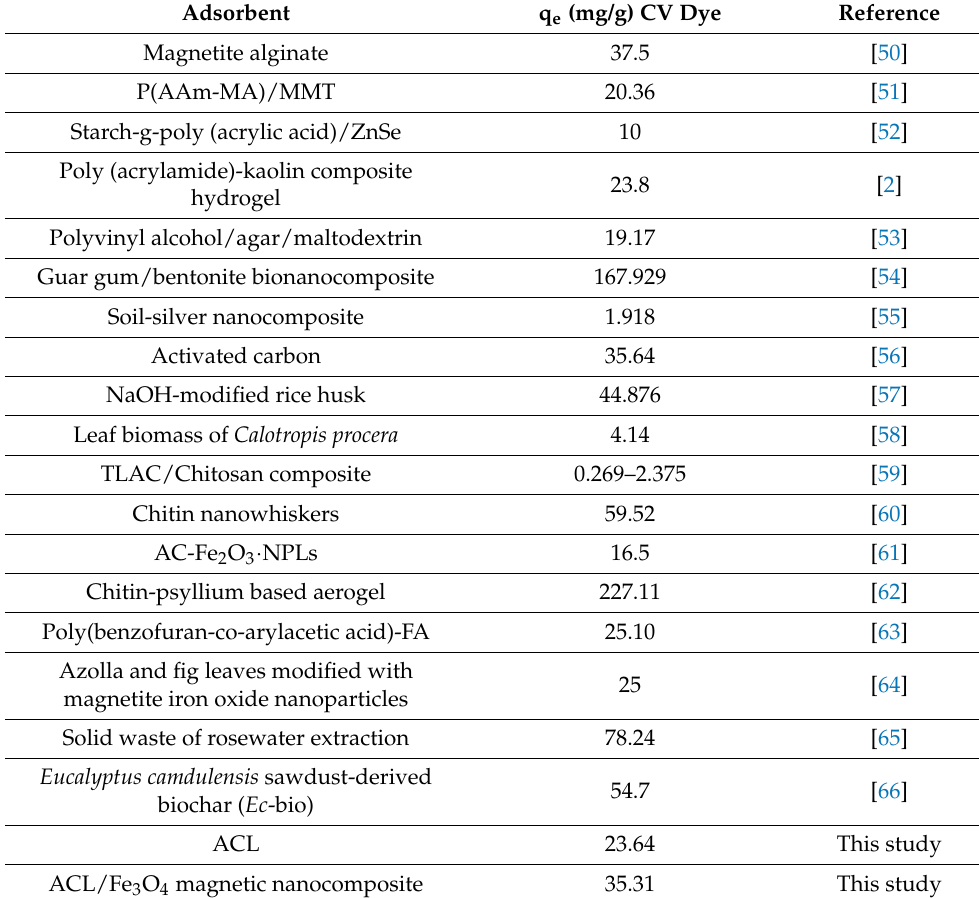
Table 4. Comparison of ACL adsorption capacity and ACL/Fe 3 O 4 magnetic nanocomposite with other adsorbents used in CV removal